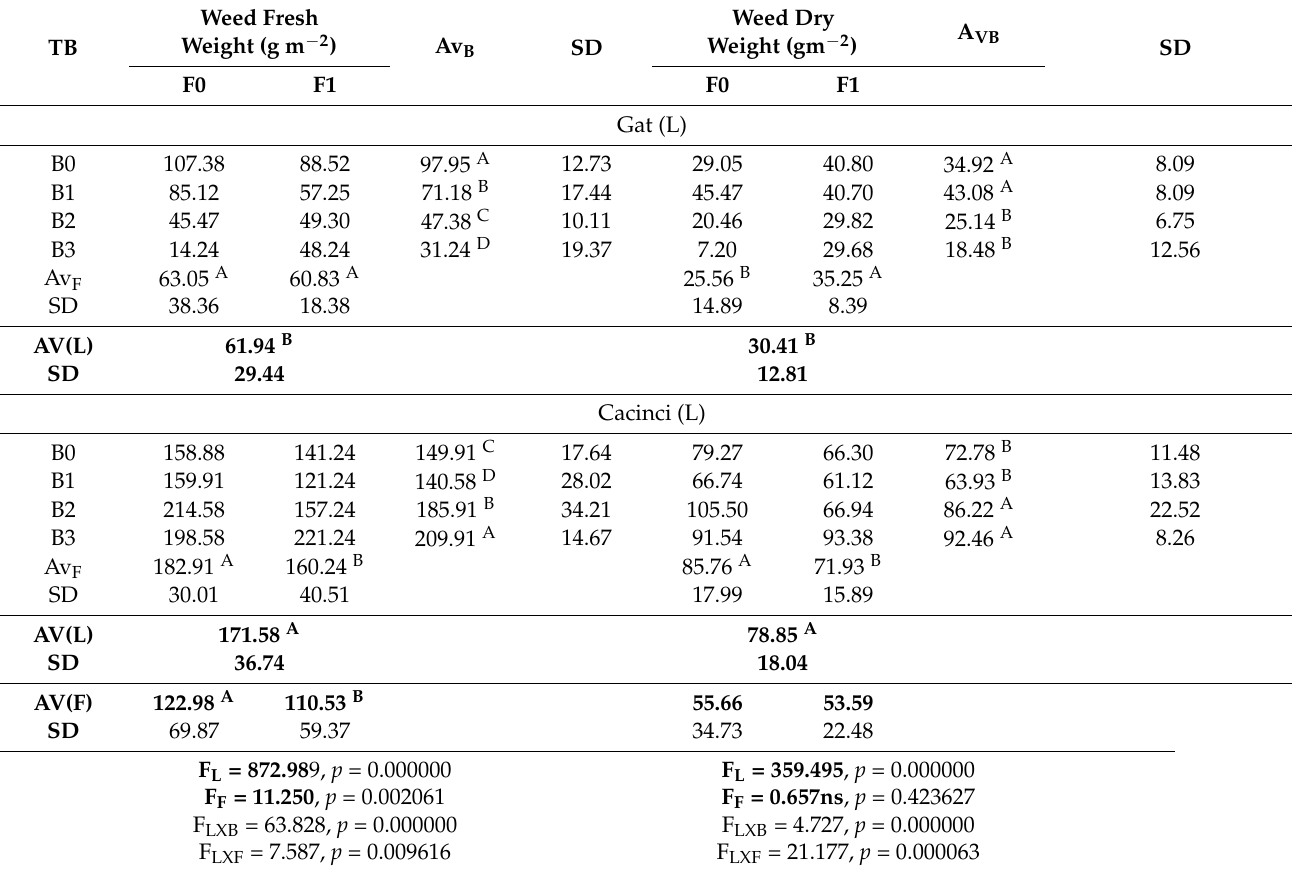
Table 7. Biochar and fertilization effects on weed fresh and dry